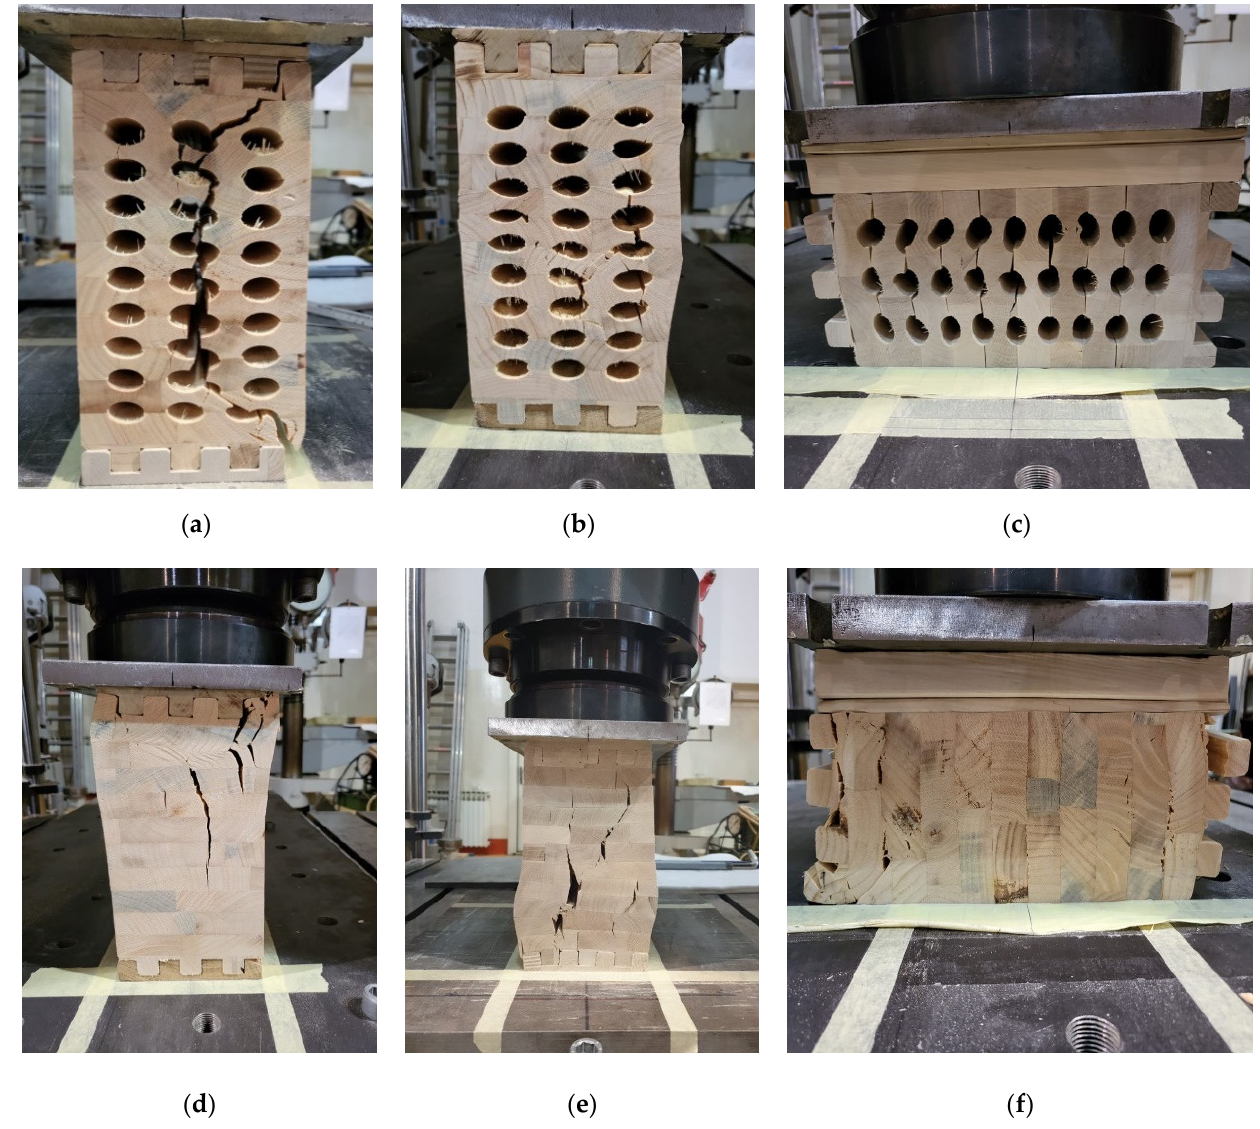
Figure 10. Failure modes characteristic for group of specimens: ( a ) ME - 209 mm; ( b ) TE - 209 mm; ( c ) ME - 400 mm; ( d ) MP - 209 mm; ( e ) TP - 209 mm; ( f ) MP - 400 mm.